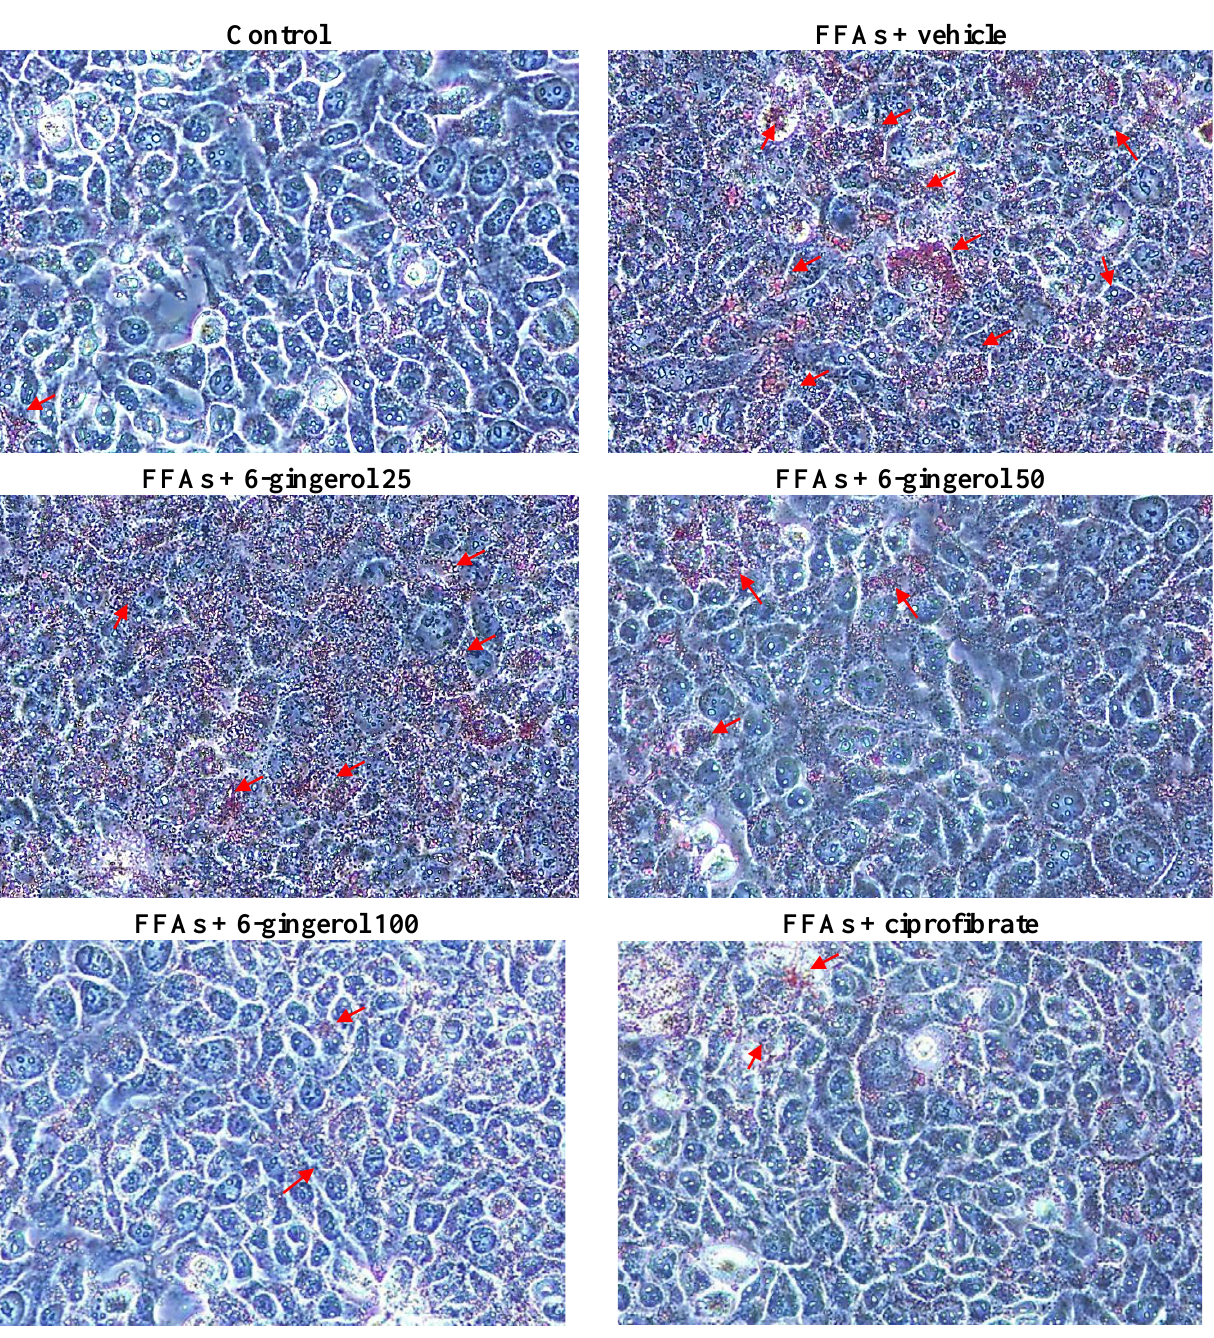
Figure 1. Representative images of FFAs mixture-treated HepG2 cells stained with Oil Red O after different treatments. HepG2 cells were exposed to a FFAs mixture (0.33 mmol/L palmitate and 0.66 mmol/L oleate) for 24 h, and were then incubated for another 24 h with 6-gingerol at concentrations of 25 μmol/L (6-gingerol 25), 50 μmol/L (6-gingerol 50), or 100 μmol/L (6-gingerol 100), or with 100 μmol/L of ciprofibrate (ciprofibrate). The vehicle (distilled water) used to prepare the test medication solutions was given at the same volume. Cells supplemented with medium without any treatment served as control. Cells were observed by light microscopy at a magnification of 400×. Arrows indicate fat